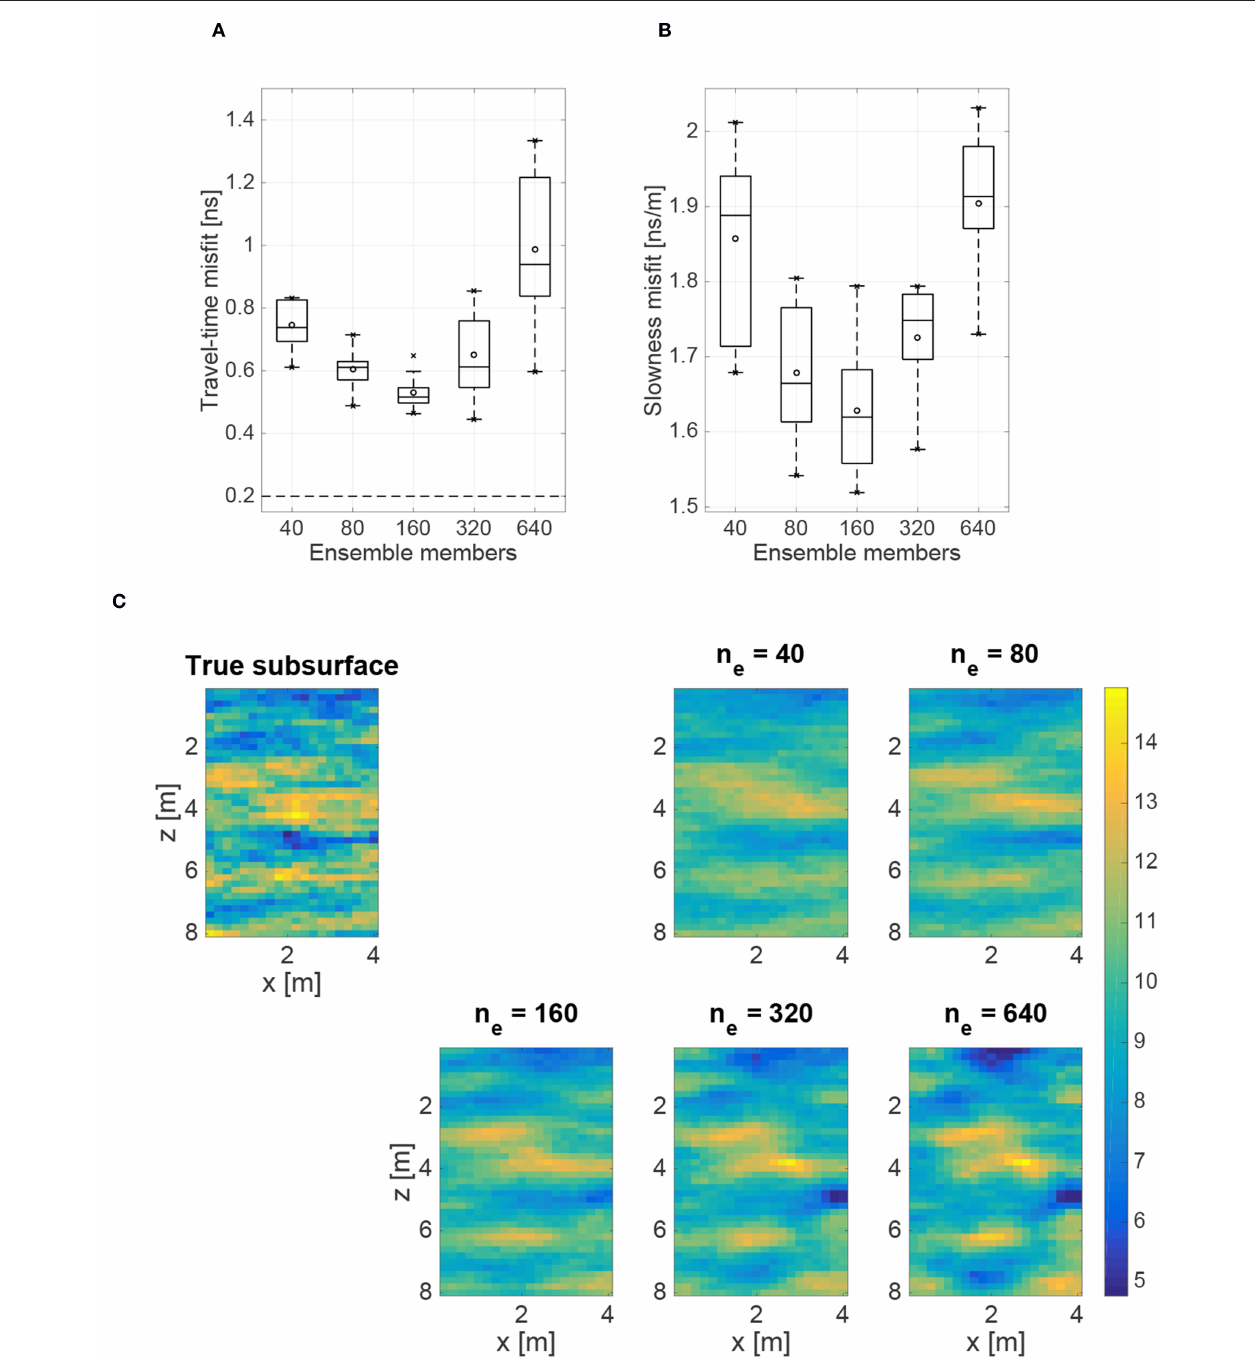
FIGURE 5 | Results of 10 runs of our modified ES-MDA algorithm to account for model error, with 40 detailed solver calculations and 40 KNN. Shown as a function of the number of ensemble members, n e , are (A) box plots of the average RMS travel-time misfit [ns]; (B) box plots of the average RMS slowness misfit [ns/m]; and (C) the mean posterior slowness fields [ns/m]. Added to the box plots are the mean (circles), and minimum and maximum values (crosses). The dashed horizontal line in (A) represents the expected value of the travel-time misfit assuming that the residuals follow the prescribed Gaussian distribution for the data